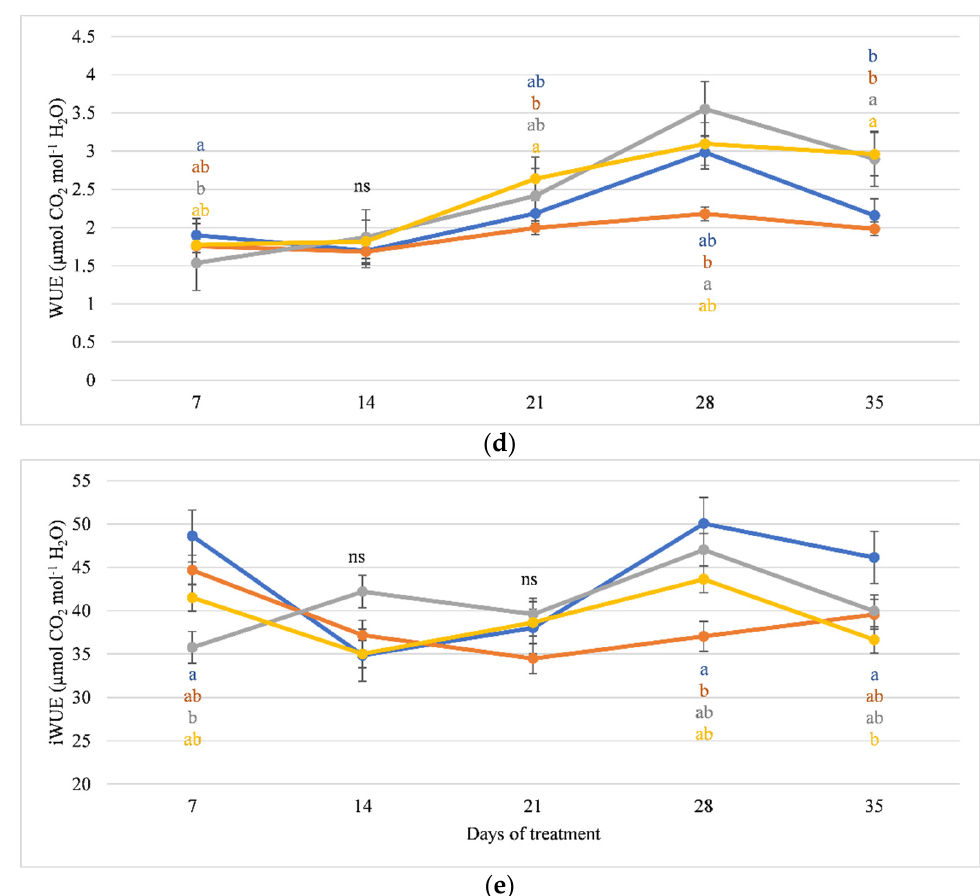
Figure 3. Effect of high EC of nutrient solution on net CO 2 assimilation intensity (P N ) ( a ), stomatal conductance (g s ) ( b ), transpiration intensity (E) ( c ), photosynthetic water use efficiency (WUE) ( d ), instantaneous photosynthetic water use efficiency (iWUE) ( e ), of cucumber plants depending on the applied medium on 7, 14, 21, 28, 35 DAEC (average from two years). Vertical bars indicate ± standard deviation. Abbreviations: ns, not significant. Average values marked with the same letters are not significantly different within the analyzed parameter at p < 0.05